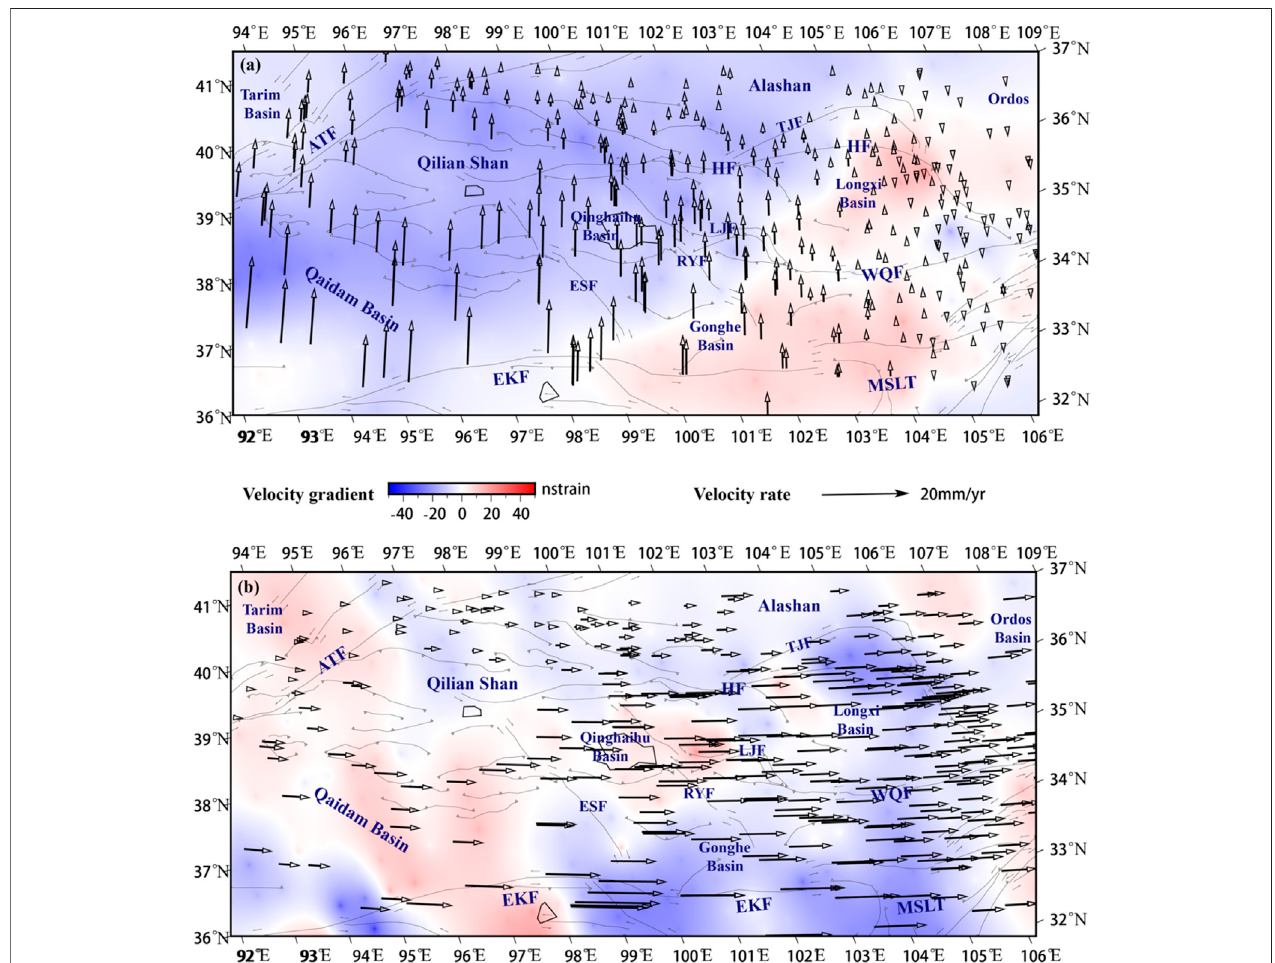
FIGURE 2 | (A) GPS velocity component perpendicular to the trend of the QFTB superimposed on the map of its gradient. (B) GPS velocity component along the QFTB superimposed on the map of its gradient.